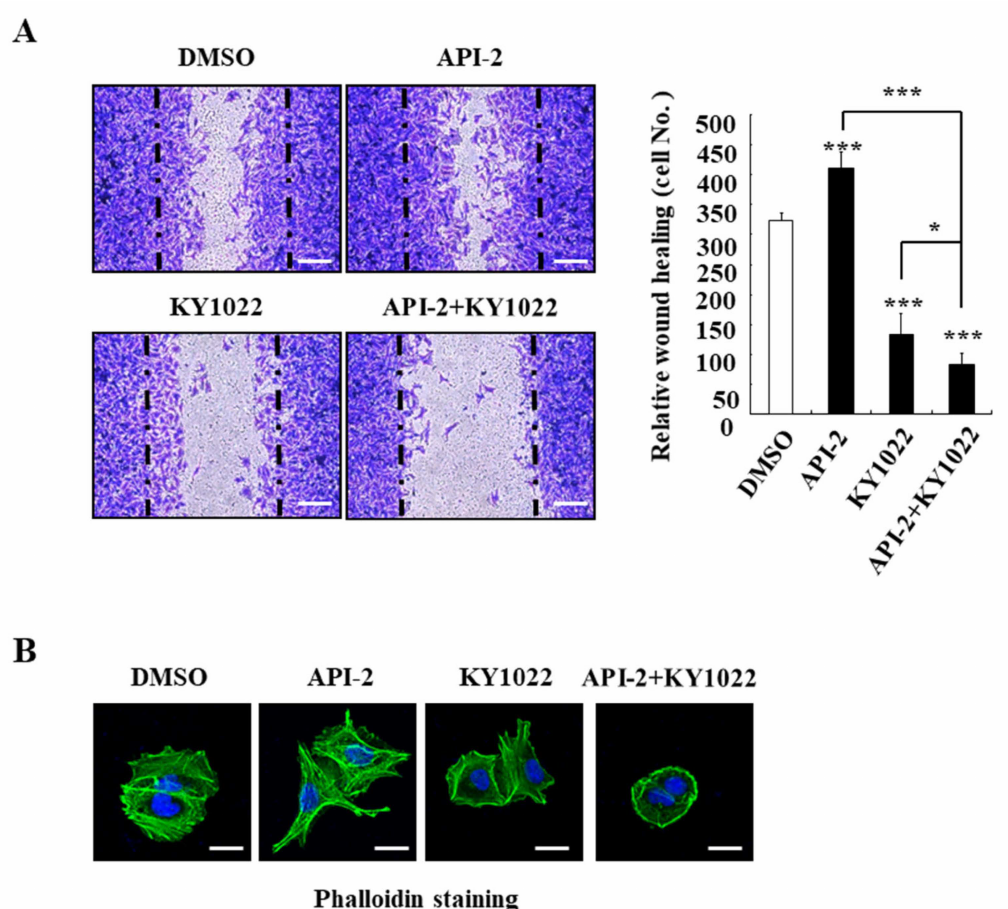
Figure 3. Effects of KY1022 on the API-2-induced cell migration and the actin rearrangement of CRC cells. ( A ) Wound-healing assay using LoVo cells after treatment of API-2 (10 µ M), KY1022 (20 µ M), and their combinations stained by crystal violet. Representative images ( n = 4 per group) were visualized by Nikon TE2000U (Kanagawa, Japan) (left panel), and the total number of migrated cells was quantified using NIS-Elements AR 3.1 software (right panel). Scale bar = 100 µ m. * p < 0.05 and *** p < 0.001. ( B ) LoVo cells were incubated with treatment of API-2 (10 µ M), KY1022 (20 µ M), and their combinations, and the cells were stained with phalloidin (green) and counterstained with DAPI (blue). Representative images were captured by using an LSM700 (Zeiss) confocal microscope ( n = 4 per group). Scale bars = 20 µ